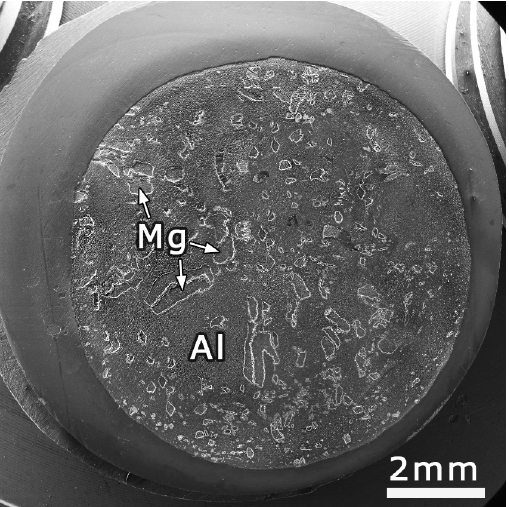
Figure 3. SEM image (SE mode) of the surface of the Al-Mg nanostructured composite after HPT and annealing following ion irradiation.